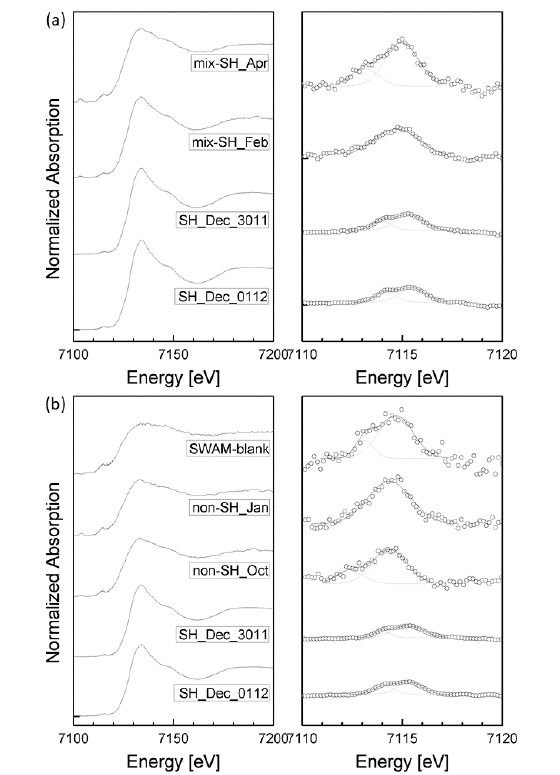
Figure 1. Lefthand panels show the XANES spectra of ( a ) Saharan dust PM 10 samples (SH_Dec_3011 and SH_Dec_0112) and mixed Saharan PM 10 samples (mix-SH_Feb and mix-SH_Apr); ( b ) Saharan dust PM 2.5 samples (SH_Dec_3011 and SH_Dec_0112), non Saharan PM 2.5 samples (non-SH_Oct and non-SH_Jan) and SWAM blank filter. A blow-up of the pre-edge features of the same samples is reported in the corresponding righthand panels. Herein the open circles are the experimental points and the lines the model best